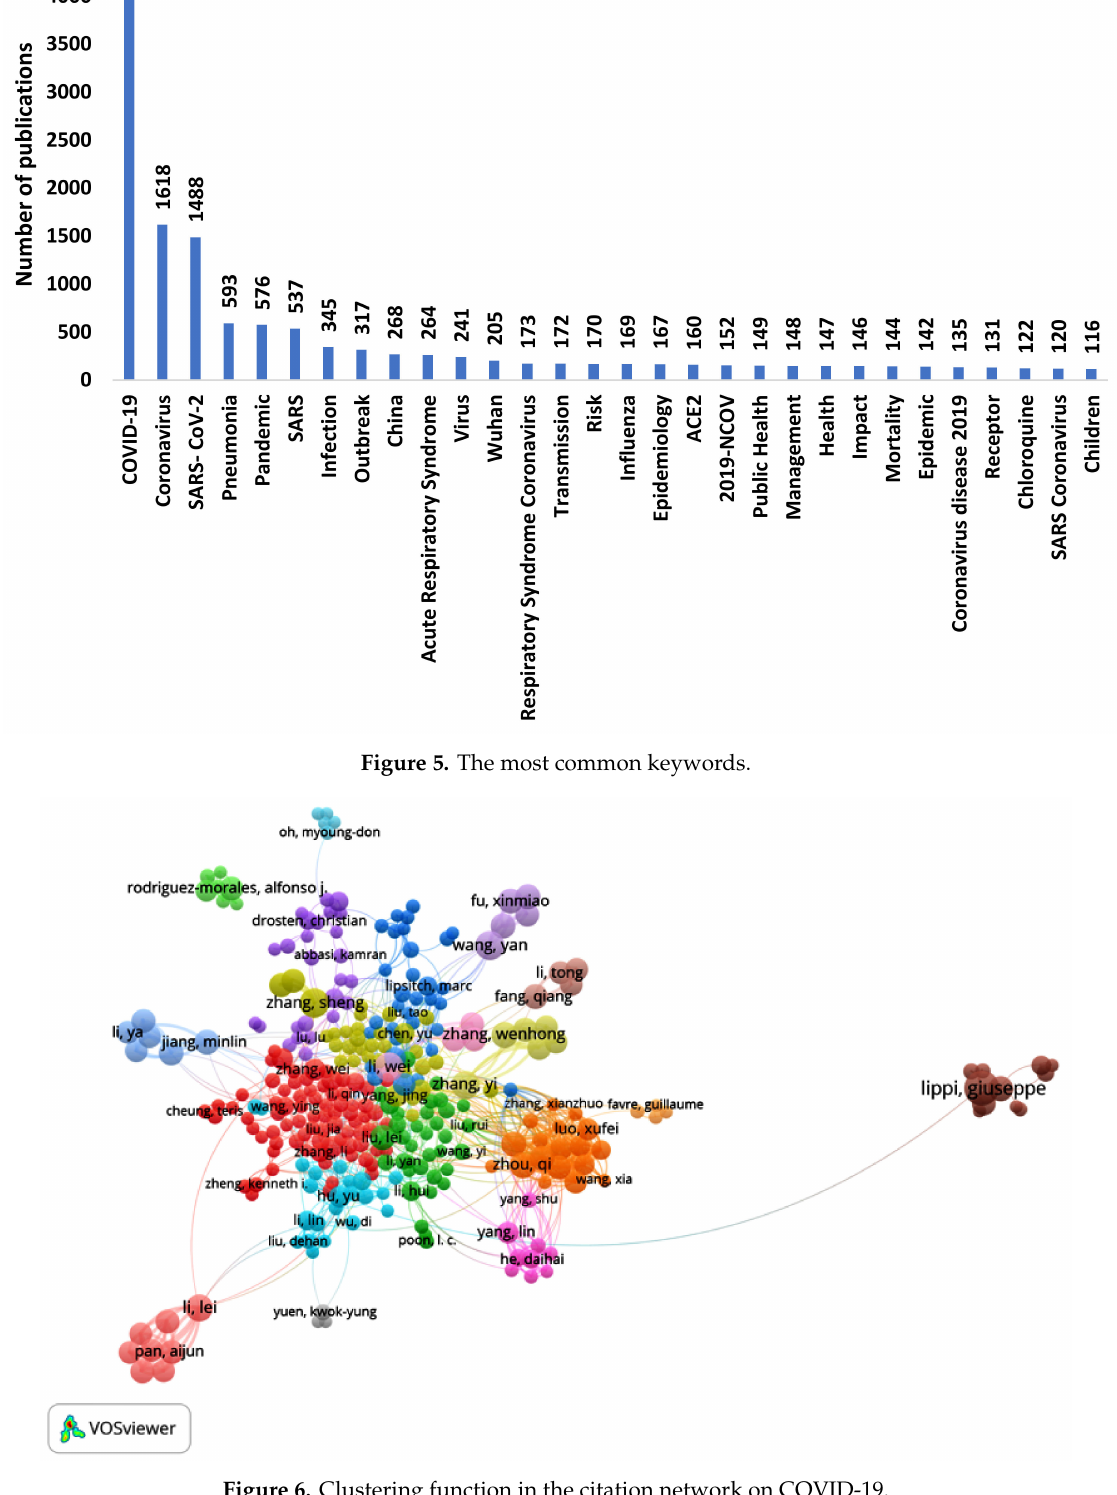
Figure 6. Clustering function in the citation network on